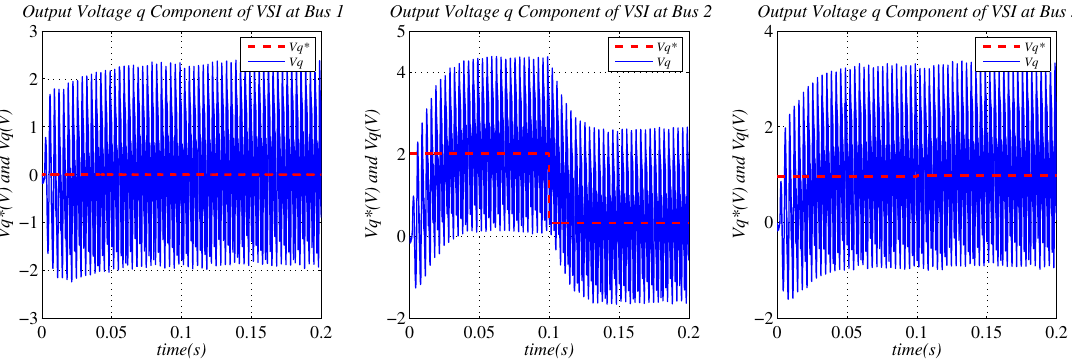
Figure 18. Output voltage q component of the VSI at Buses 1, 2, and 3 with the nonlinear load. To show the scalability of the proposed control scheme, a microgrid of six buses with five VSIs shown in Figure 20 was also simulated. In this simulation, the VSI parameters Rt , Lt , and Ct were changed at + 40% of their nominal values, to check the performance of the controller in the presence of parametric uncertainty. The load variation was also considered in this simulation. The line impedances Z A , Z B , and Z C were the same as in previous simulations. The line impedances Z D and Z E were considered the same as Z B and Z C , respectively. VSI at Buses 2, 3, 4, and 5 shared 5%, 10%, 15%, and 20% of the total load connected at bus 6, respectively. The remaining load was shared by the VSI connected at Bus